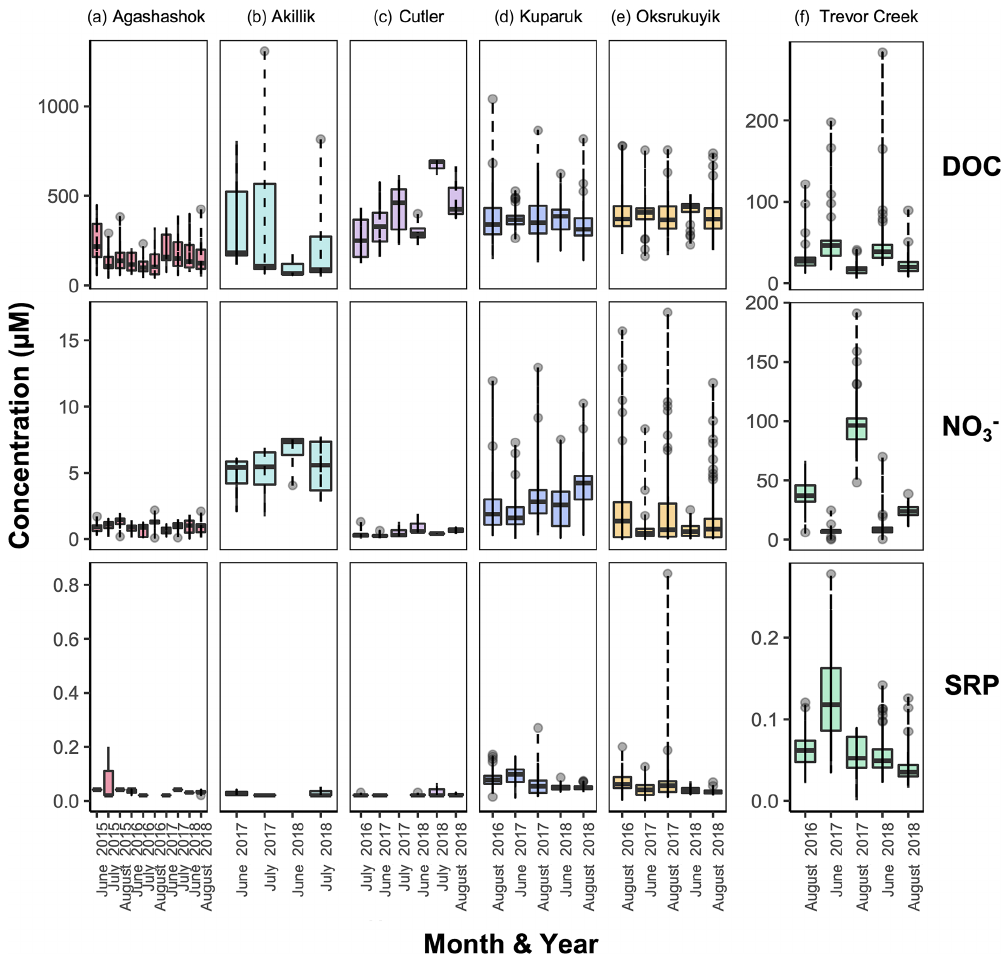
Figure 4. Boxplots of dissolved organic carbon (DOC, top row), nitrate (NO 3 − , middle row), and soluble reactive phosphorus (SRP, bottom row) concentration ranges (in µM) in the (a) Agashashok River, (b) Akillik River, (c) Cutler River, (d) Kuparuk, (e) Oksrukuyik Creek, and (f) Trevor Creek watersheds across all years and seasons sampled. Each box encapsulates values within the lower 25th and upper 75th quartiles respectively, while the whiskers represent the minimum and maximum quartiles. Within each box, the horizontal line represents the median leverage value. Data points outside the whiskers represent values above and below 1 . 5 × the interquartile range (IQR)